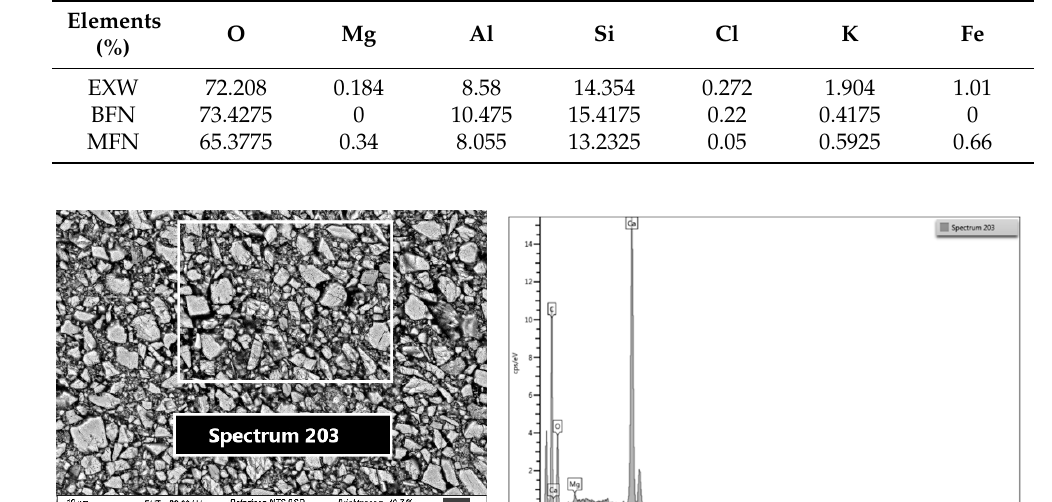
Table 8. Relative phase contents (%) from the XRD results by the Rietveld